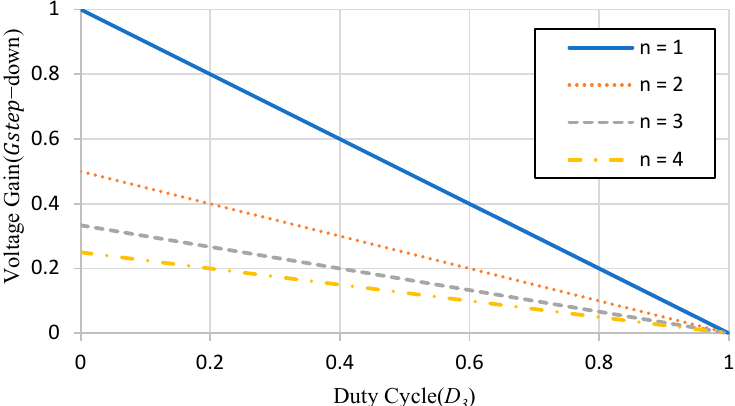
Figure 8. Plot of the voltage gain versus the duty cycle in the step-down mode.